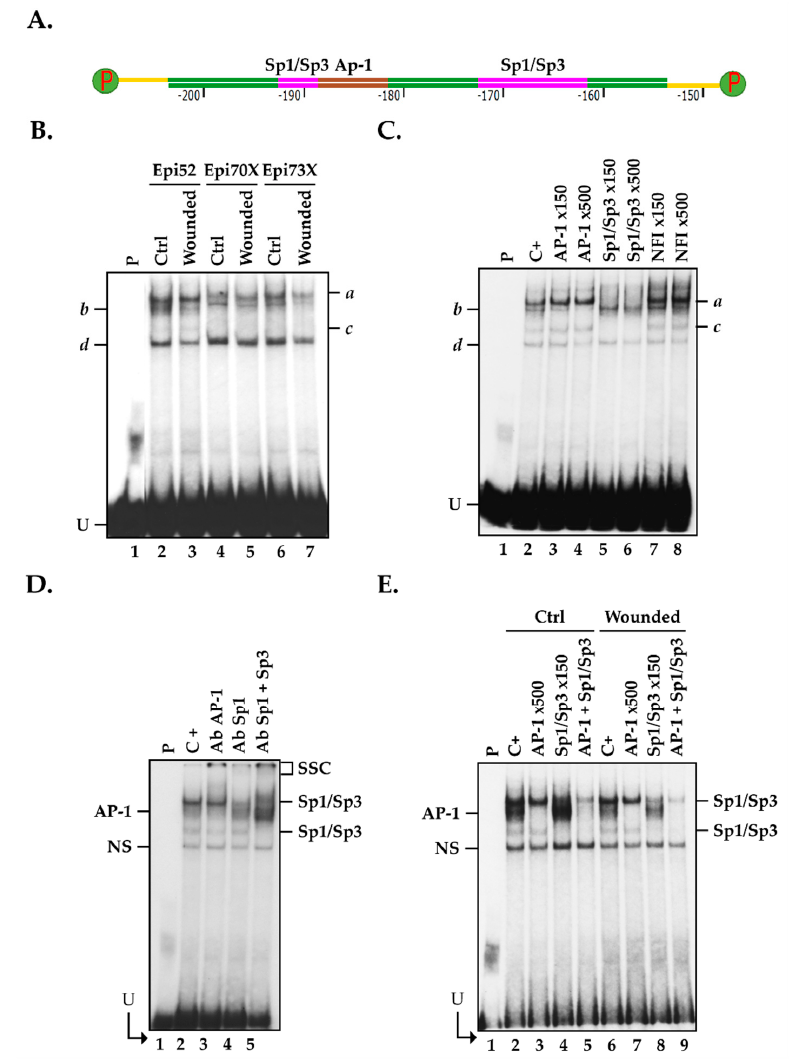
Figure 4. Expression and binding of the TFs AP-1 and Sp1/Sp3 to the CLU basal promoter region using nuclear extracts from hCECs. ( A ) Schematic representation of the 50 bp segment from the human CLU promoter (-153 to -203) used as a labeled probe in EMSA that also bears putative binding sites for AP-1 (from -188 to -182 (brown)) and Sp1/Sp3 (from positions -194 to -186 and -170 to -161 (pink)). ( B ) Nuclear proteins (15 μ g) prepared from three different populations of hCECs (Epi52, Epi70X and Epi73X) were incubated with the CLU-labeled probe and formation of DNA-protein complexes monitored by EMSA. ( C ) Nuclear proteins from unwounded hCECs (Epi 70X) were incubated with the CLU-labeled probe either alone (C+) or in the presence of a 150- or 500-fold molar excess of unlabeled competitor oligomers bearing the high affinity recognition target site for AP-1, Sp1/Sp3 or NFI. ( D ) HCECs nuclear proteins (Epi70X) were incubated with the CLU-labeled probe either alone (negative control: C+) or with antibodies that can recognize the c-Fos or c-Jun AP-1 isoforms (Ab AP-1), or Sp1 and/or Sp3 prior to separation of the DNA-protein complexes by EMSA. SSC: supershifted complexes formed upon addition of the antibodies. ( E ) Nuclear proteins from unwounded (Ctrl) or scratch-wounded (Wounded) hCECs (Epi 52) were incubated with the CLU probe either alone (C+) or in the presence of either a 150- or 500-fold molar excess of unlabeled competitor oligomers bearing the target site for either AP-1 or Sp1/Sp3. The positions of both the AP-1 and Sp1/Sp3 DNA-protein complexes are indicated. P: labeled probe without added proteins; U: free probe; N.S.: non-specific complex.